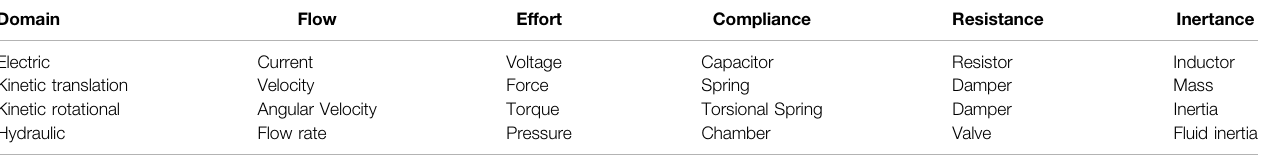
TABLE 2 | Analogy between some conventional physical domains, reproduced from Borutzky (2011).